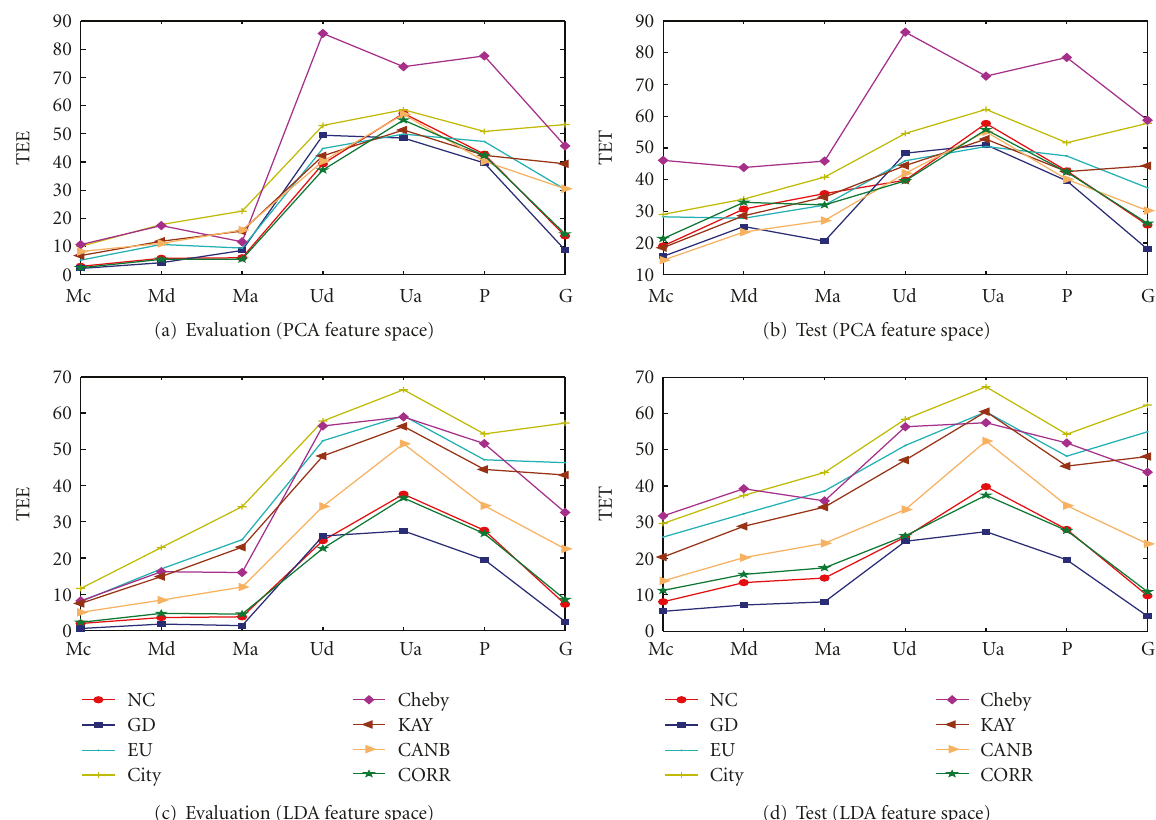
Figure 2: ID verification results using di ff erent scoring functions in the PCA and LDA feature spaces for the manually registered data.